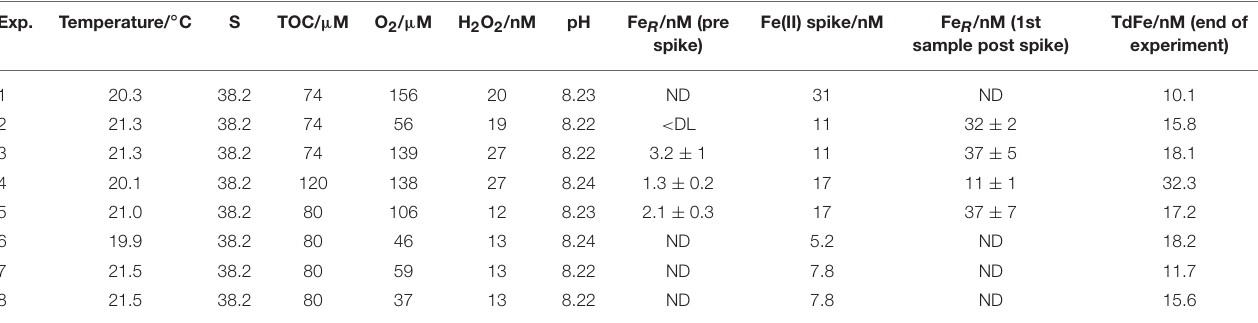
TABLE 2 | Experimental conditions for a series of method comparison experiments where an Fe(II) spike was added to Mediterranean seawater and the concentration of Fe(II) then measured continuously until below detection. Exp.